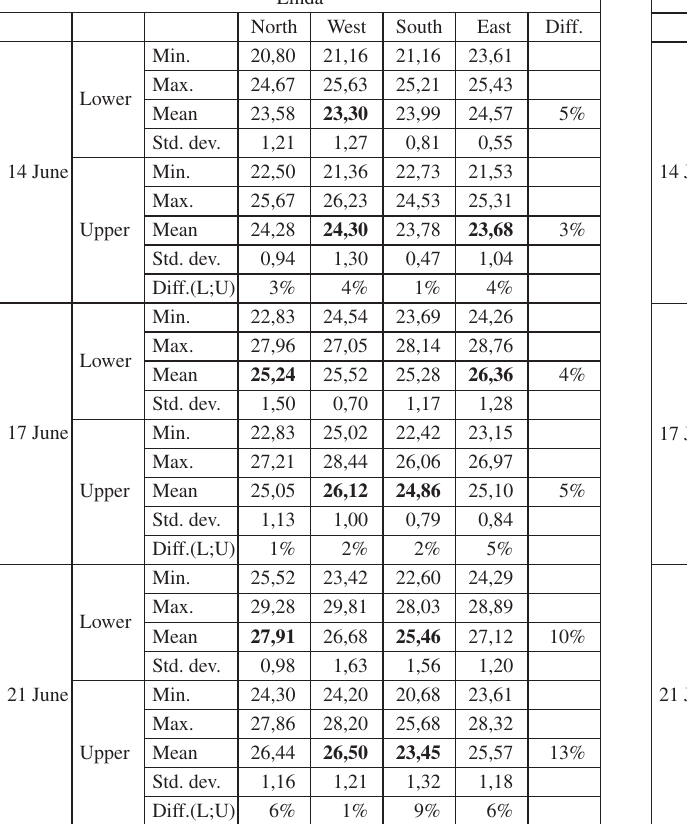
Table 1: The values of the widths of the samples Linda North West South East Diff.